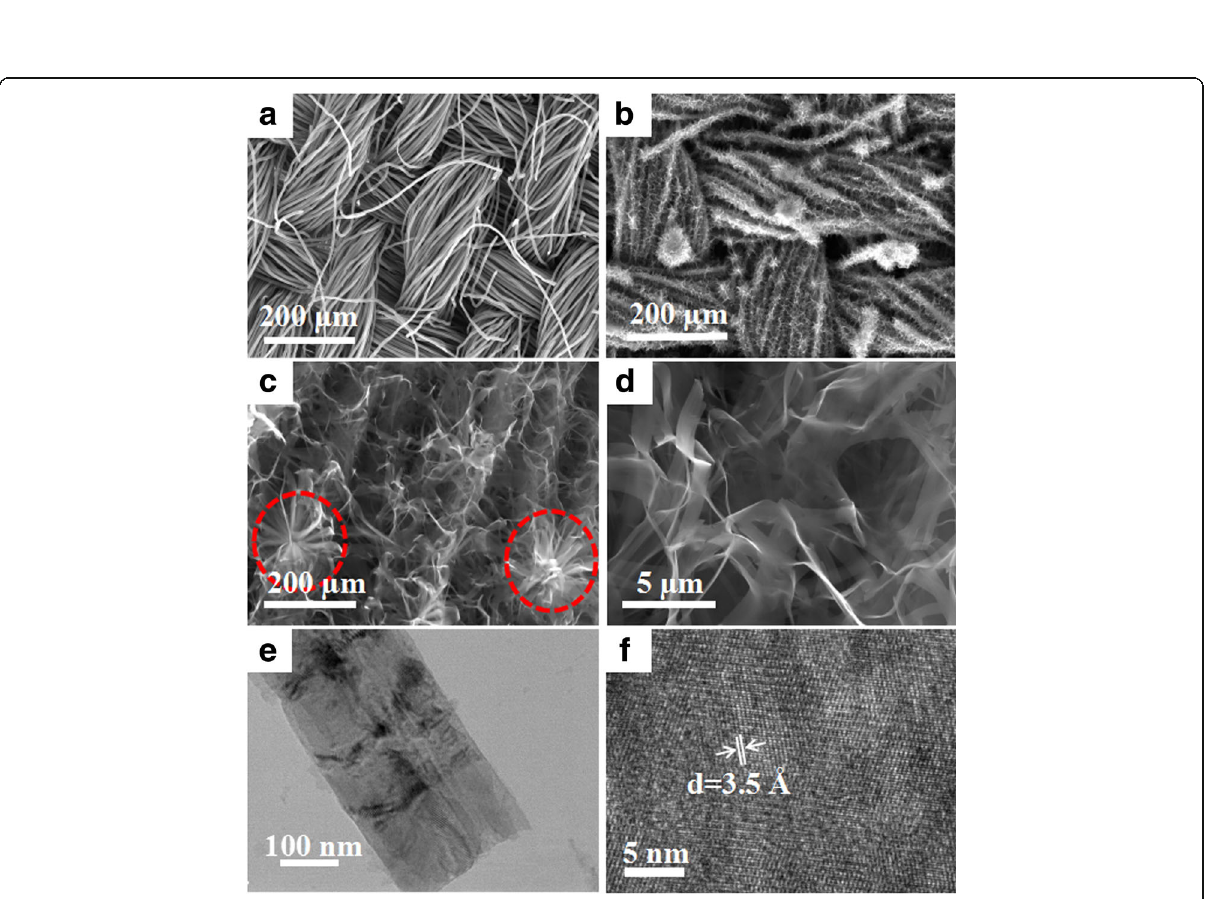
Fig. 2 Microstructure of 3D free-standing interconnected V 6 O 13 nanosheets on c-textile: a , b low resolution SEM images of c-textile without and with nanosheets, respectively; c , d high-resolution SEM images of interconnected nanosheets grown on c-textile; e , f low- and high-resolution TEM images of the nanosheet,